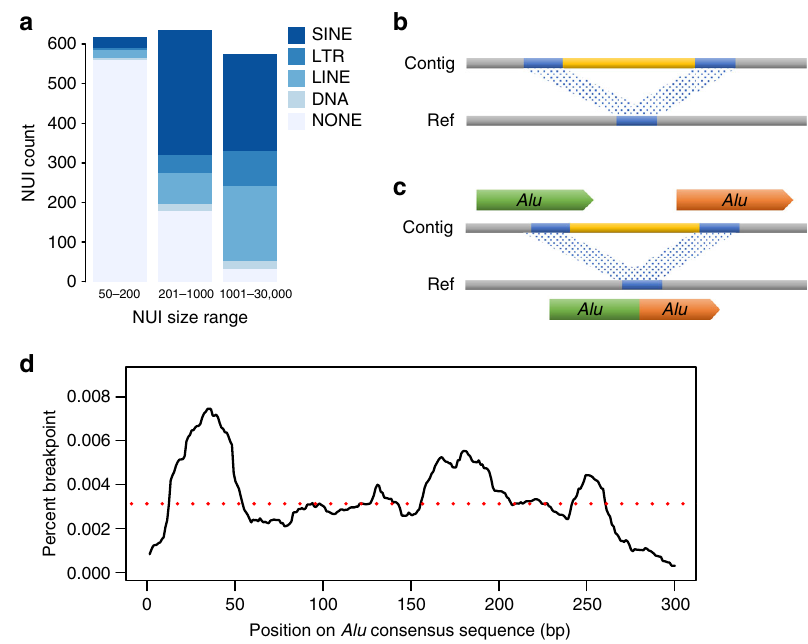
Fig. 3 Characteristics of non-reference unique insertions. a Major transposable element in each NUI split by three different size ranges. Stacked bars represent the total number of NUI in each size range. SINE short interspersed nuclear element, LTR long terminal repeat, LINE long interspersed nuclear element, DNA DNA transposon, NONE no interspersed repeat detected. b Example of an overlapping alignment in the reference where both ends of the NUI are homologous. Yellow block, NUI; blue blocks, homologous sequences; contig, a stretch of sequence containing the NUI; ref, reference. c When two Alus recombine ectopically, the resulting alignment, as shown in the reference strand, becomes a chimeric Alu . d Percentage of breakpoint along an Alu consensus sequence. The red dashed line represents the average breakpoint percentage (0.0033%)